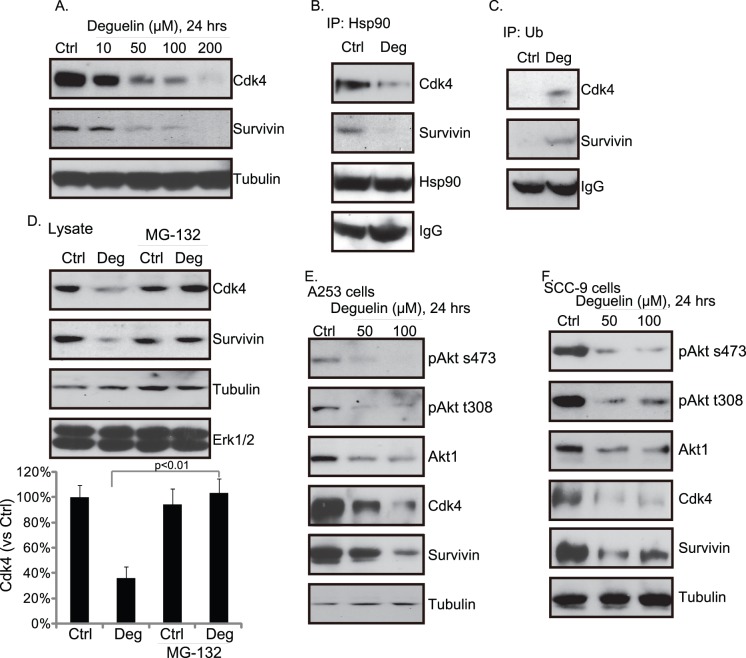
Deguelin down-regulates survivin and Cdk4.Hep-2 cells were exposed to deguelin at indicated concentration (10, 25, 50 and 100 µM) for 24 hours, expression levels of survivin, Cdk4 and tubulin were measured by western blot (A).The association between survivin, Cdk4 and Hsp 90 as well as the association between survivin, Cdk4 and ubiquitin after deguelin treatment (Deg, 100 µM, 12 hours) were detected by immunoprecipitation (IP) assay (B–C). Effect of MG-132 (1 µM, 12 hour pretreatment) on deguelin-induced Cdk4 and survivin degradation was shown in (D). Western blots was performed to test the expression of Akt, phos-Akt, survivin, Cdk4 and tubulin after deguelin treatment in A253 (E) and SCC-9 cells (F). The mean of at least three independent experiments performed in triplicate is shown. Statistical significance was analyzed by ANOVA.